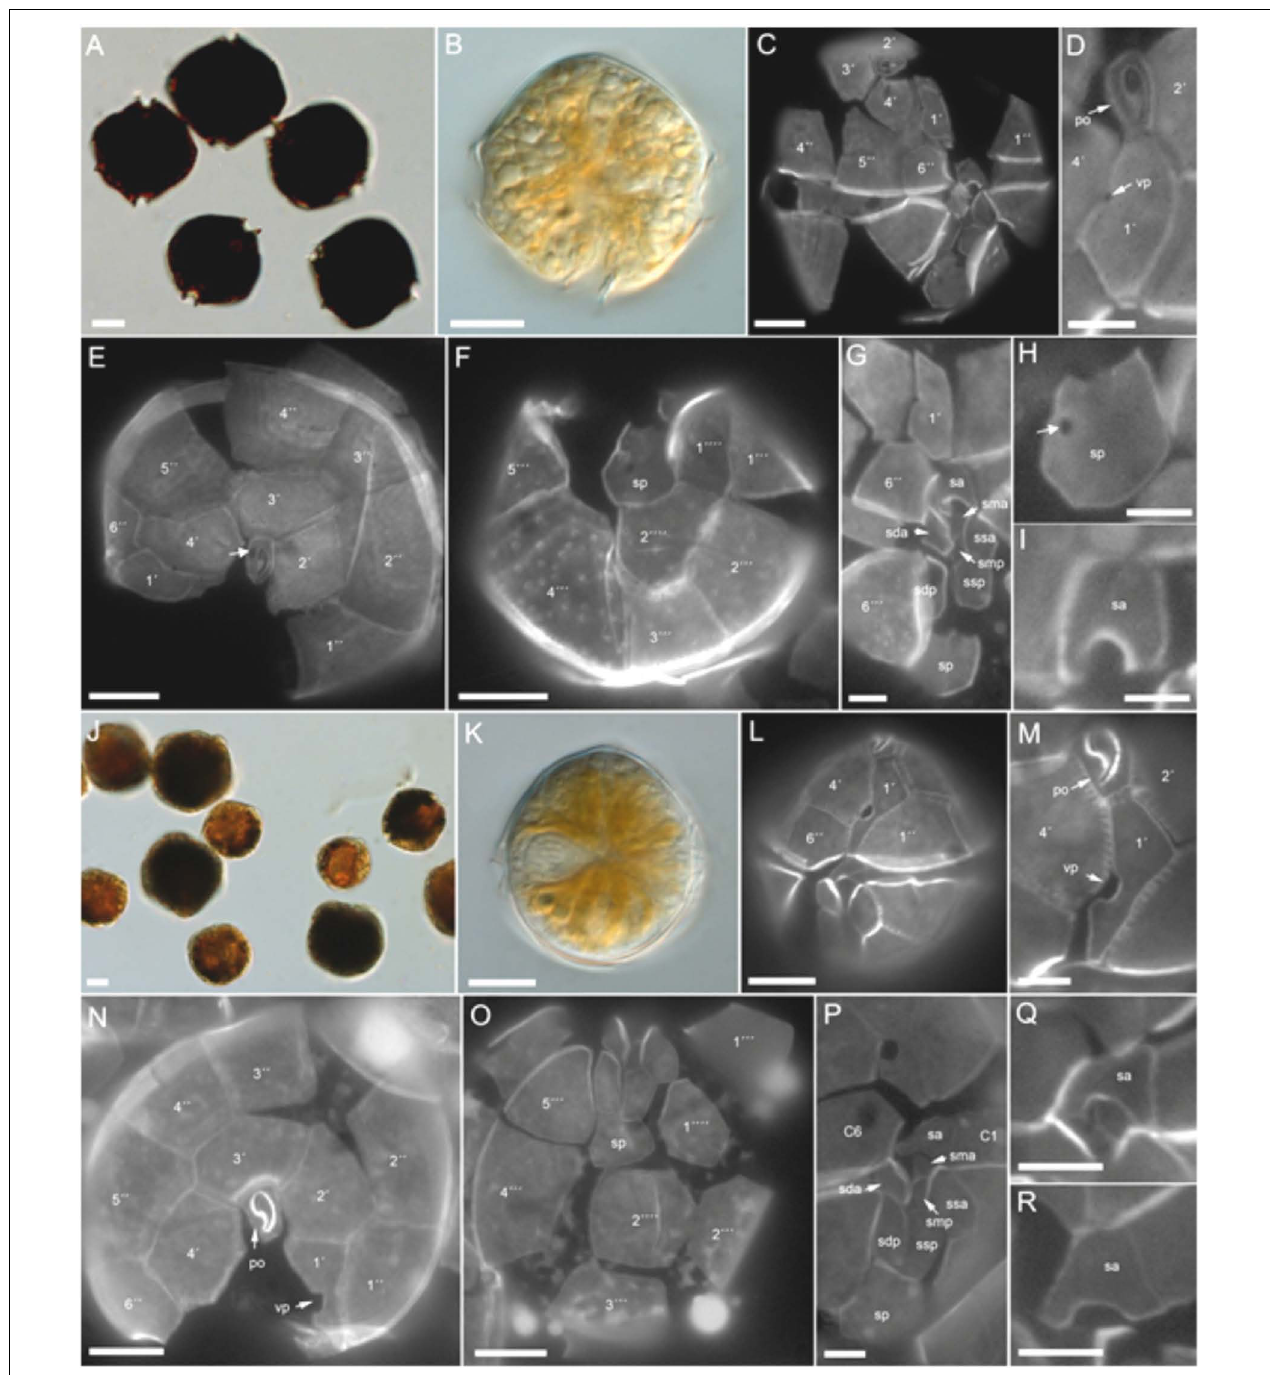
FIGURE 8 | Alexandrium spp. morphology. (A–I) A. catenella (H3-D10). Bright field images of (A) lugol-stained or (B) living cell. Epifluorescence images of calcofluor-stained cells showing (C–G) the plate pattern, and (H) details of the posterior and (I) anterior sulcal plate. Note in (D) the ventral pore (vp) and in (E) the attachment pore on the pore plate (white arrow). (J–R) A. ostenfeldii (H-3D4). Bright field images of (J) lugol-stained or (K) living cell. Epifluorescence images of calcofluor-stained cells showing (L–P) the plate pattern, and (Q,R) details of the anterior sulcal plate. Vp, ventral pore; Po, pore plate. Plate labels according to the Kofoidean system. Sulcal plates abbreviations: sp, posterior sulcal plate; ssp, left posterior sulcal plate; sdp, right posterior sulcal plate; smp, median posterior sulcal plate; sda, right anterior sulcal plate; ssa, left anterior sulcal plate; sma, median anterior sulcal plate; sa, anterior sulcal plate. Scale bars = 10 µ m (A–C,E,F,J–L,N,O) or 5 µ m (D,G–I,M,P–R)